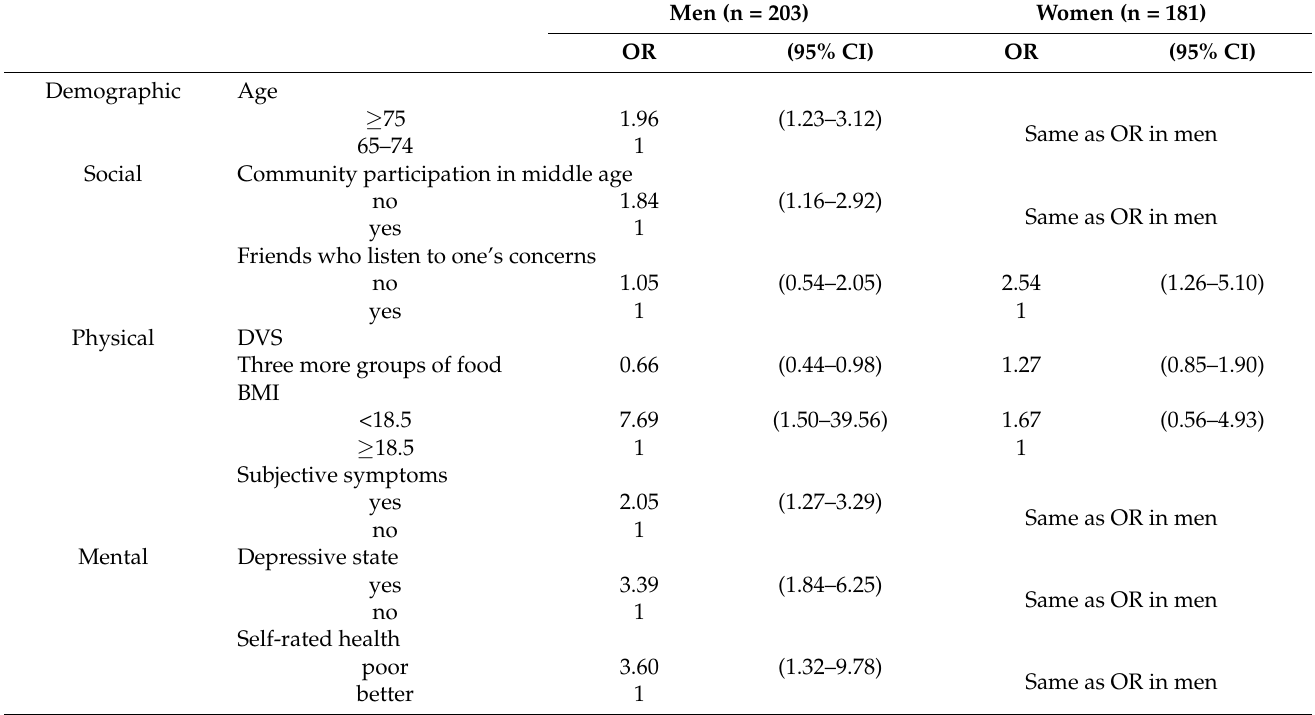
Table 2. Factors associated with pre-frailty in Japanese rural community-dwelling older